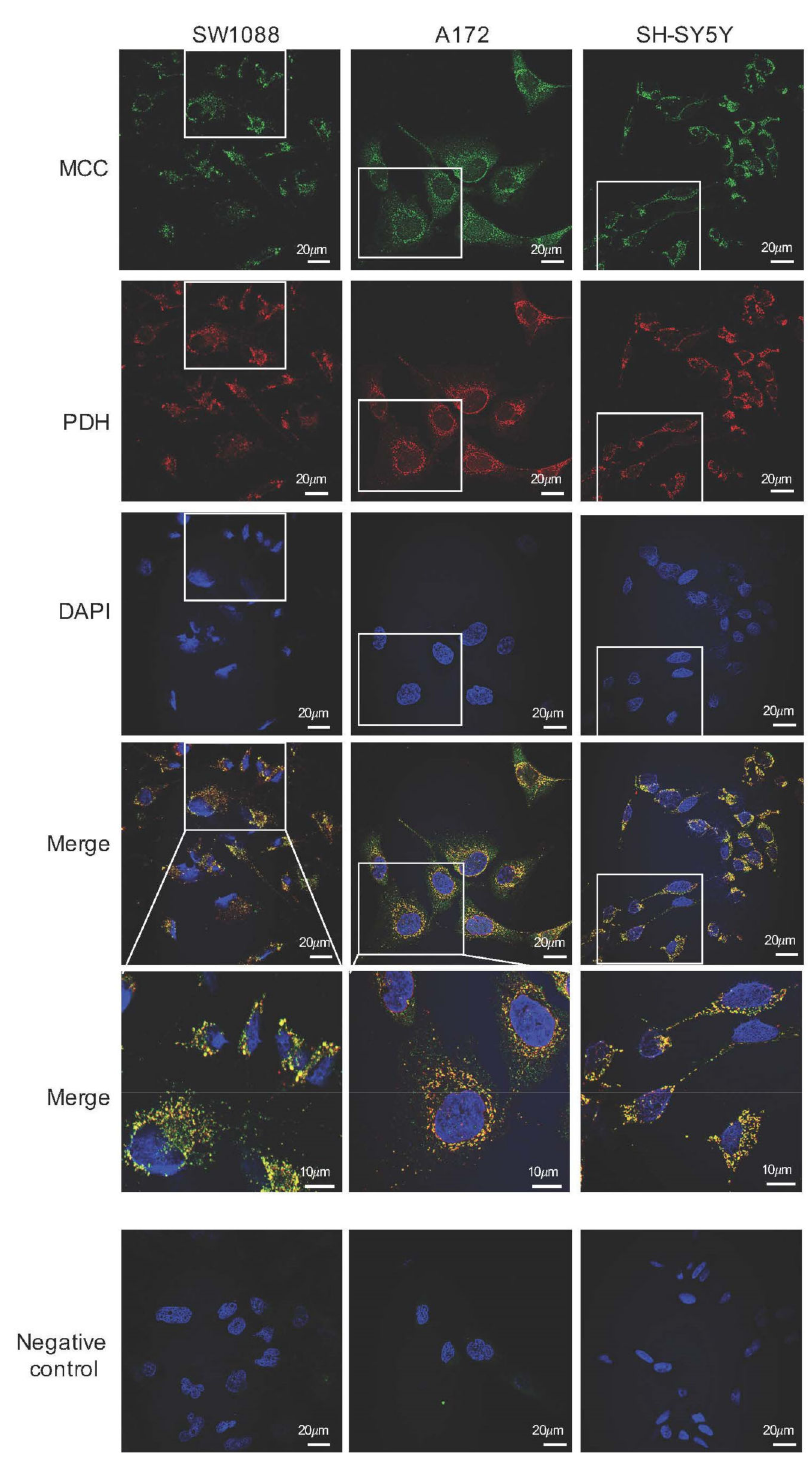
Figure 5. Immunofluorescence photomicrographs of human glioma (SW1088), glioblastoma (A172), and neuroblastoma (SH-SY5Y) cells, which were double-labeled with antibodies against the α subunit of 3-methylcrotonyl-CoA carboxylase (MCC; green) and pyruvate dehydrogenase (PDH; red). Cell nuclei were visualized by DAPI. The merged views are represented separately with higher magnifica- tions (merge). Negative control was performed by omitting the primary antibodies (negative control). The scale bars represent either 20 or 10 µ